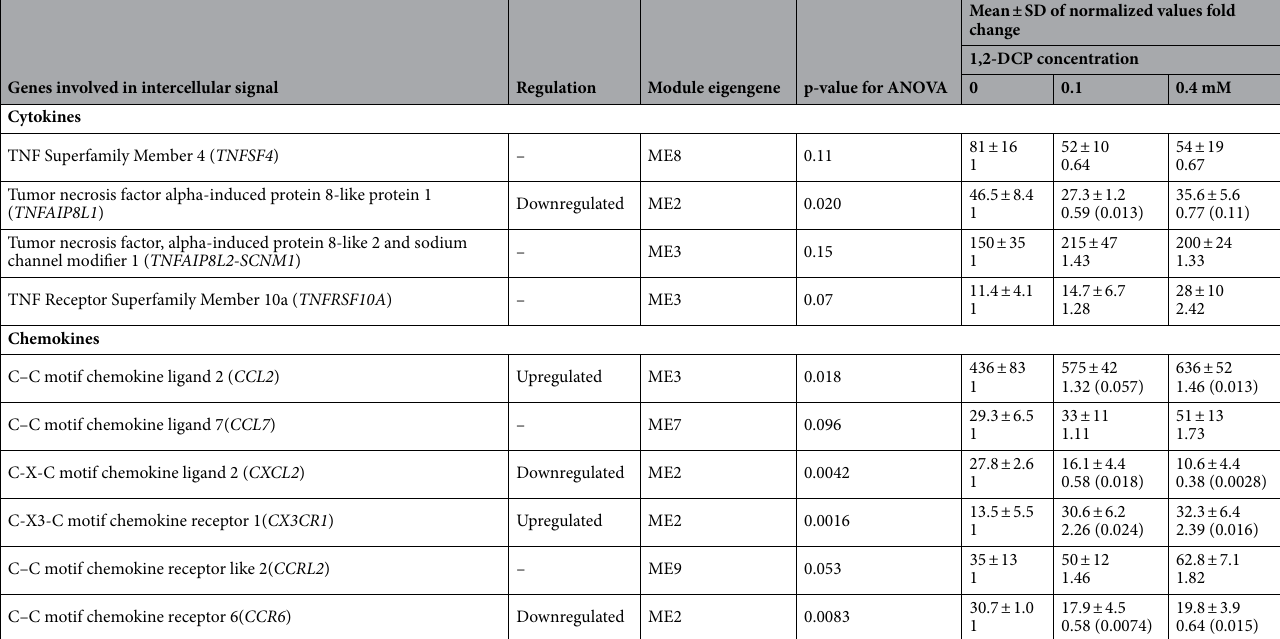
Table 6. ANOVA for expression levels of cytokines/chemokines-related genes or their receptors, which are selected by hypothesis, in THP-1 macrophages co-cultured with MMNK-1 cholangiocytes. Normalized values of expression level were compared between three groups of different 1,2-DCP concentration by one-way analysis of variance (ANOVA), being followed by post hoc Dunnett’s multiple comparison with control (0 mM 1,2-DCP group). Data represents expression levels of cytokines/chemokines-related genes or their receptors from transcriptomic profiles of THP-1 macrophages co-cultured with MMNK-1 cholangiocytes when exposed to 1,2-DCP at 0, 0.1 or 0.4 mM for 24 h. Data of normalized values for gene expression are mean ± SD, n = 3. Fold change represents the value relative to the average of the control group (0